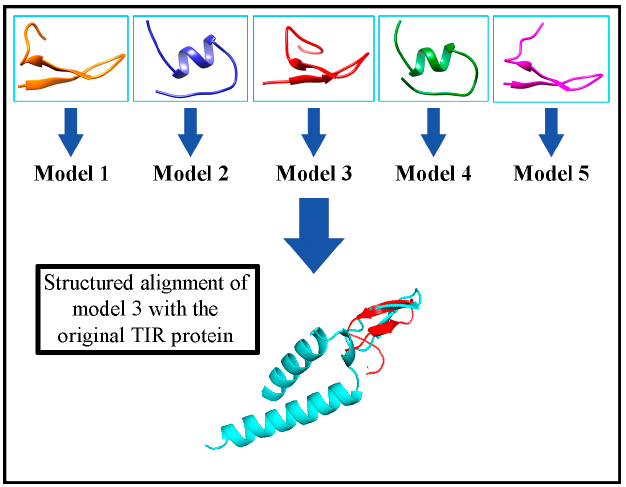
Figure 2. Three-dimensional structure of five models obtained from the sequence: QKVNIDELGNAIPSGVLKDD with the PEP-FOLD tool.